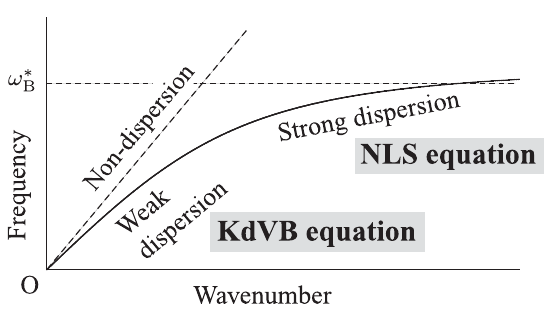
Fig. 1 The dispersion relation in bubbly liquids (3),(4),(8),(9) . Weakly nonlinear propagation of pressure waves in two frequency bands, i.e., the low frequency band and high frequency band are described by the KdVB and NLS equations, respectively. Here, ω ∗ denotes the natural frequency of a single B